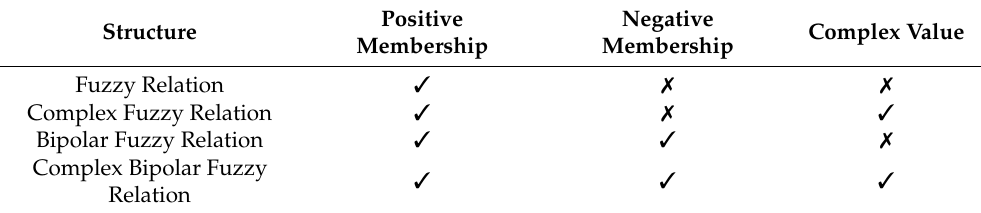
Table 8. A structural and technical comparison among different